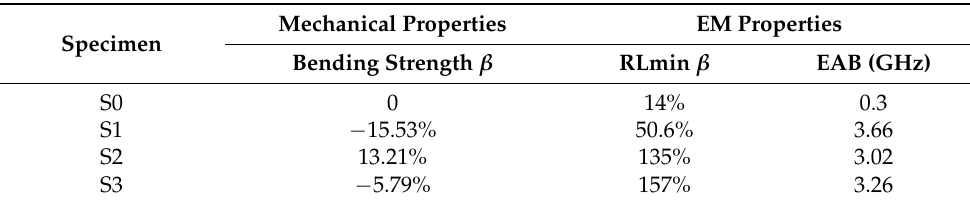
Table 3. The mechanical properties and absorbing properties of normalized the 3-D honeycomb woven EM absorbing composites. Mechanical Specimen